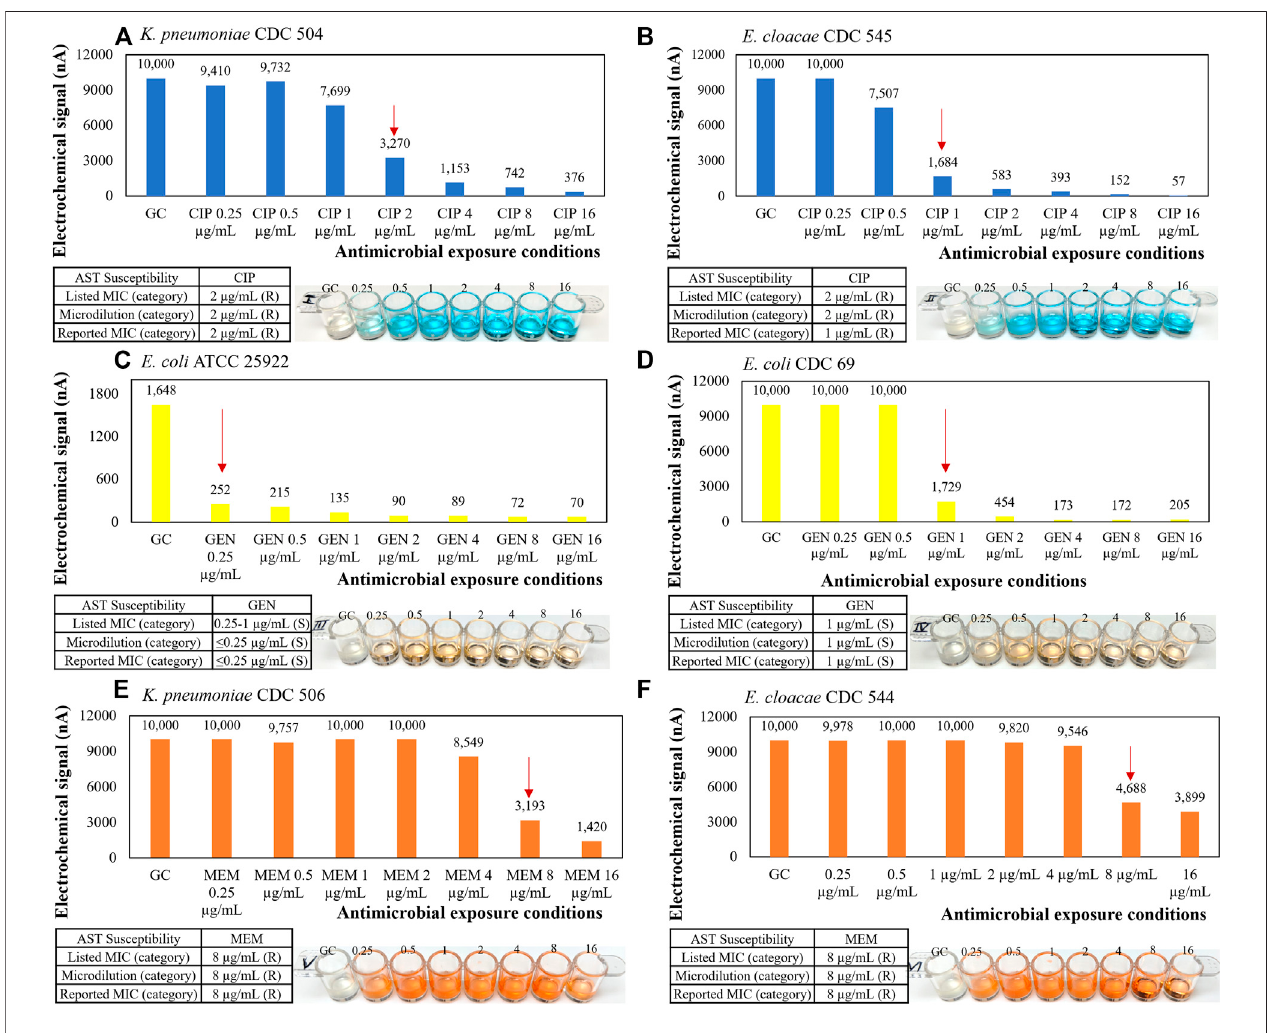
FIGURE7| RepresentativeASTresultswithmicrobiologicalresponseplottedinelectrochemicalsignallevelsinnanoamperesfor (A,B) cipro fl oxacin, (C,D) gentamicin,and (E, F) meropenem one-drug stripwells with 3-h antimicrobial exposure and corresponding CLSI microdilution result with 16 – 20-h antimicrobial exposure as a reference.